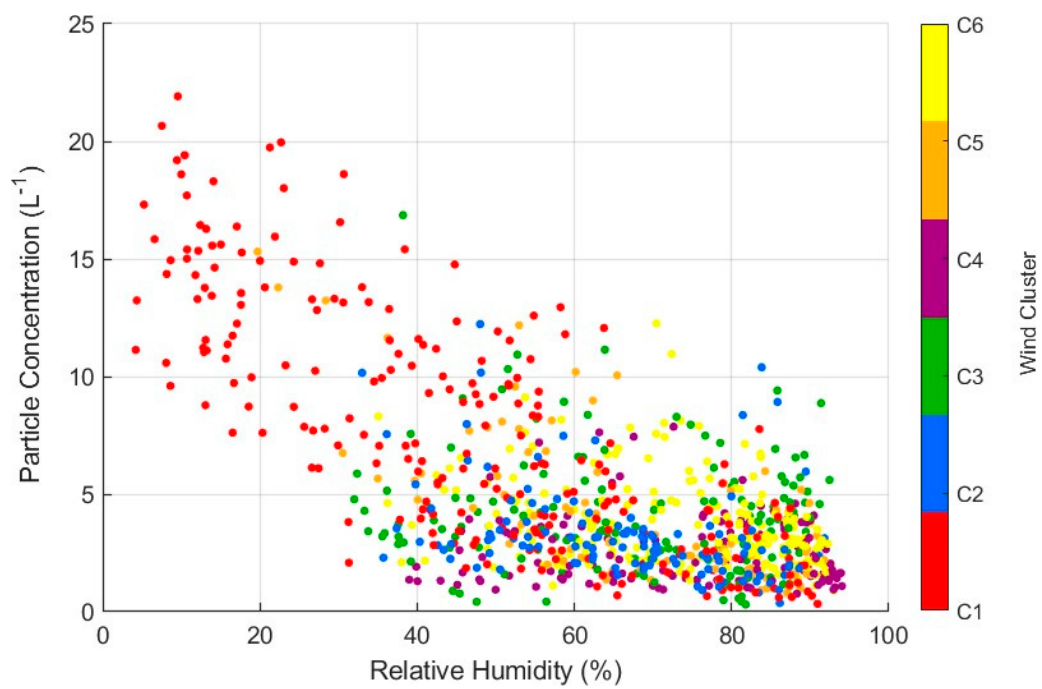
Figure 8. PLAIR Rapid-E particle concentrations (L − 1 ) as a function of relative humidity. The colourbar represents the wind cluster that was dominant at the time of recording. Data points represent three-hour averages across the entire campaign.